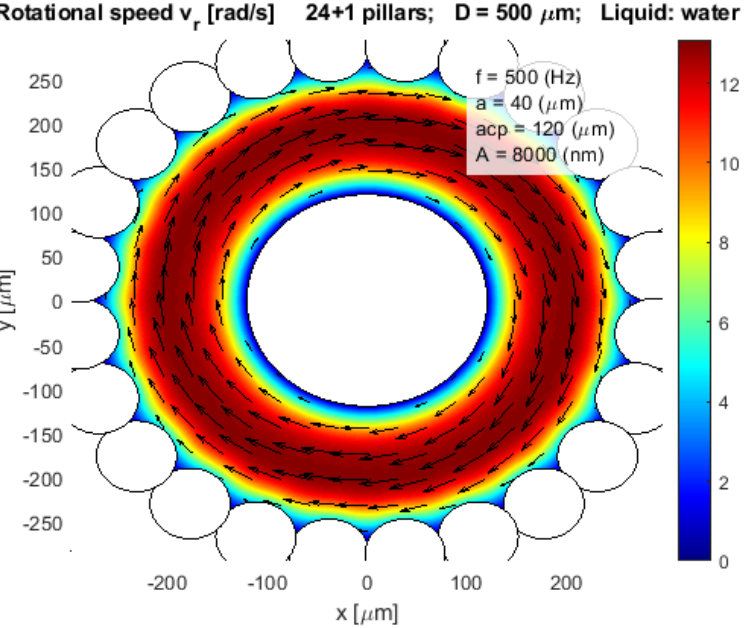
Figure 9. Rotational velocity of water stream 𝑣 𝑟 in a closed pot-like layout with a large central pillar.